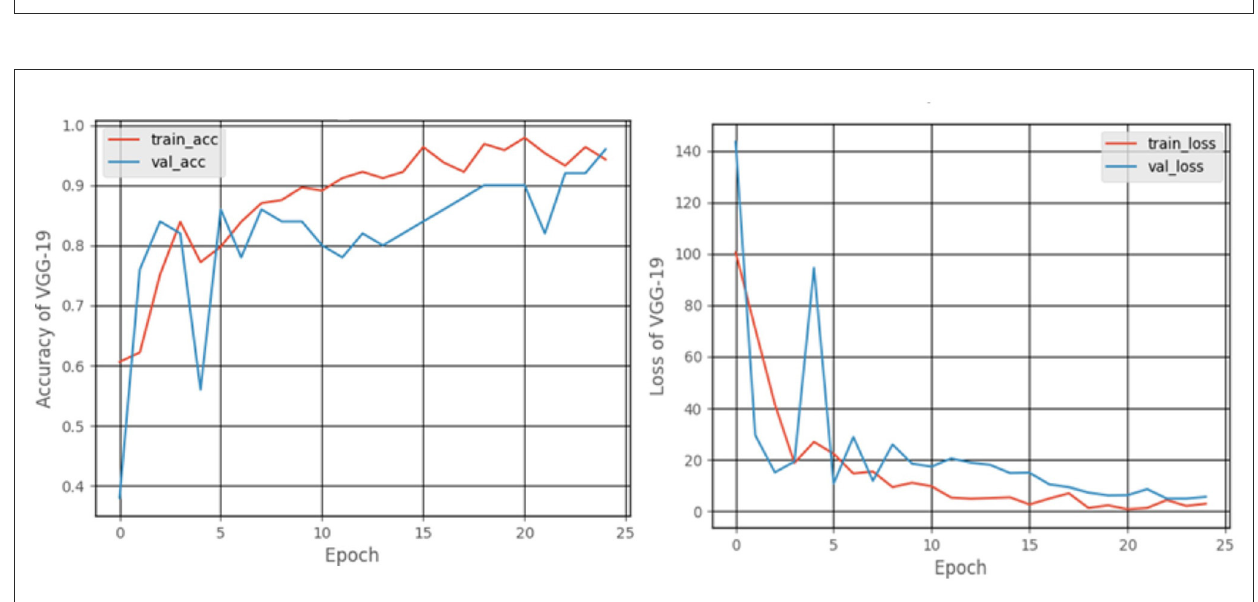
FIGURE10 Accuracy and loss graphs for the VGG-19